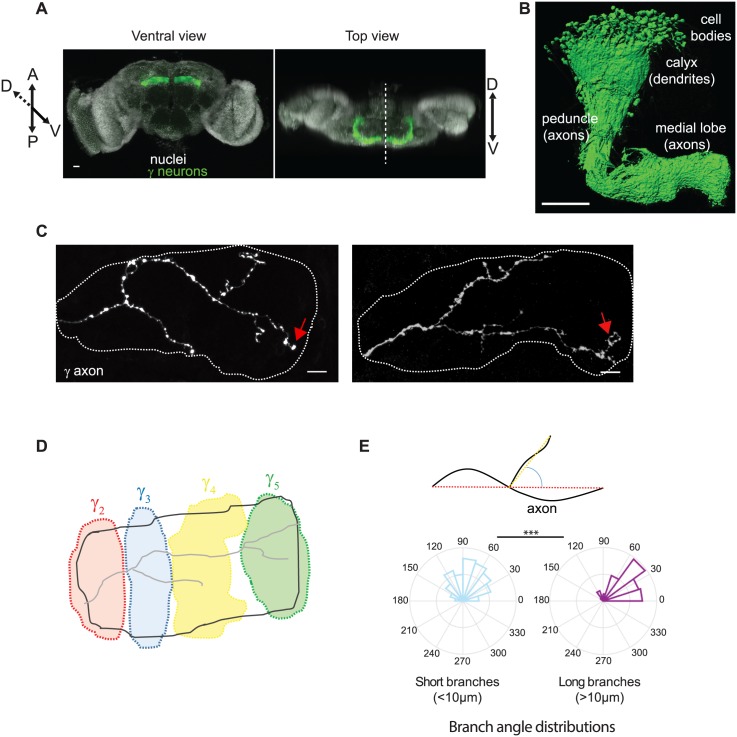
Characteristics of adult Mushroom Body γ neurons.(A) Wild-type adult Drosophila brain expressing the membrane-tagged CD8-GFP construct in γ neurons, under the control of the MB009B-Gal4. Nuclei are labeled in white with DAPI. The dotted line on the top view image corresponds to the midline. (B) 3D reconstruction of one Mushroom Body where γ neurons only were labeled. Genotype: MB009B-Gal4/UAS CD8-GFP. (C) Axonal arborizations of two individual adult γ neurons labeled by GFP using the MARCM technique. Confocal images taken along the z axis were projected (Maximum Intensity Projection). Dotted lines delimit the shape of the medial lobe. Red arrows indicate axon tips that reached the extremity of the medial lobe. (D) Schematic representation of the different anatomical domains (distinguished with different colors) defined along the medial lobe and innervated by distinct input and output neurons. Adapted from [34]. Scale bars: 20 μm in A, 50 μm in B and 10 μm in C. (E) Top panel: schematic representation of how directionality angles were measured. We have considered the angle between the vector defined by the first and last point of the mother branch (red segment), and the vector defined by the first and last point of the considered branch (yellow segment) projected on the xy plane. Bottom panel: frequency distribution of the directionality angles of long (>10 μm, type I) and short (<10 μm, type II) branches measured on reconstructed wild-type adult γ axons. The frequency values are presented as a percentage of each group (n = 97 and 283 for type I and II branches respectively). The middle circle represents 10 and 15% for type II and I respectively. *** stands for p = 4.4−13 (Kruskal Wallis test).